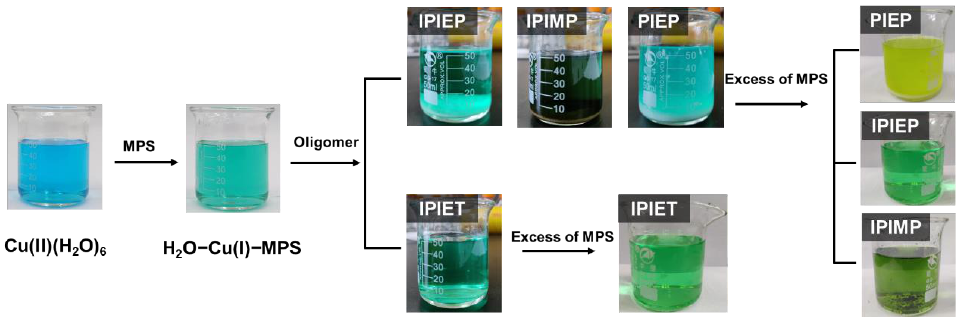
Figure 8. Series of photos demonstrating the coordination reactions between oligomers, Cu(I), and